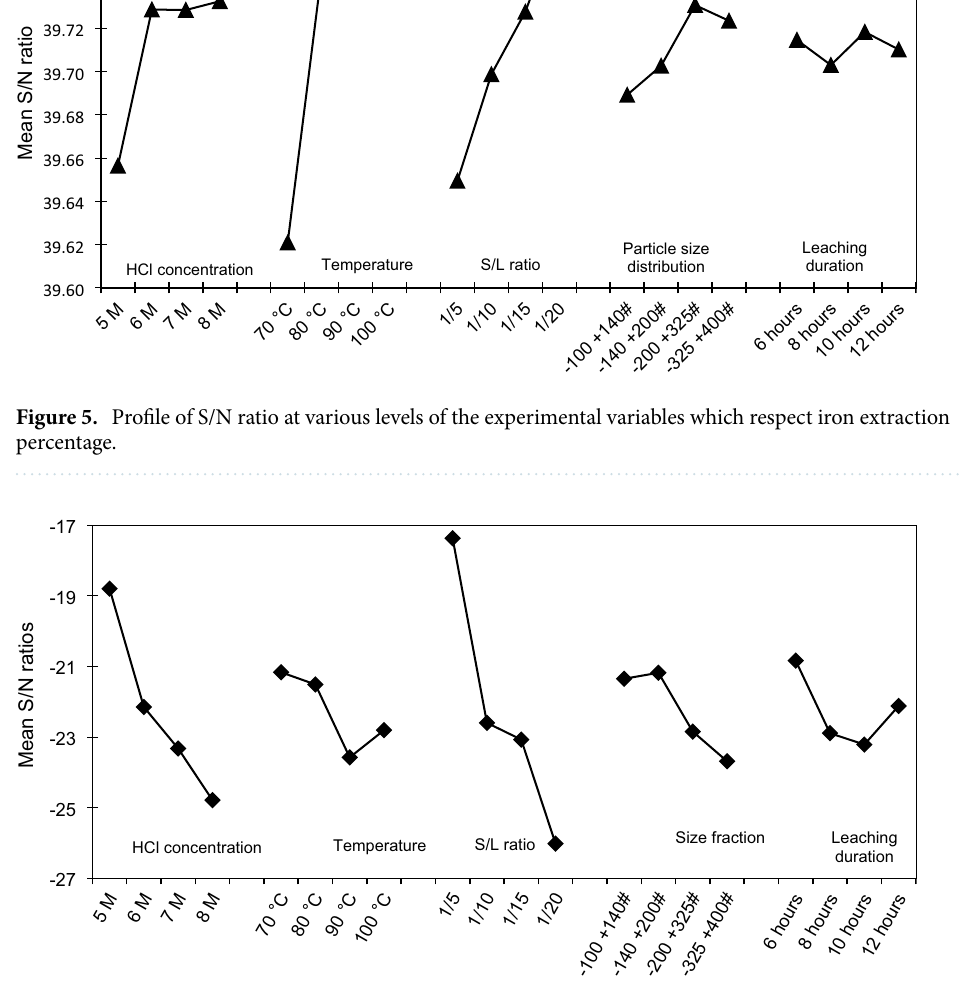
Figure 6. Profile of S/N ratio at various levels of the experimental variables which respect to titanium co-extraction